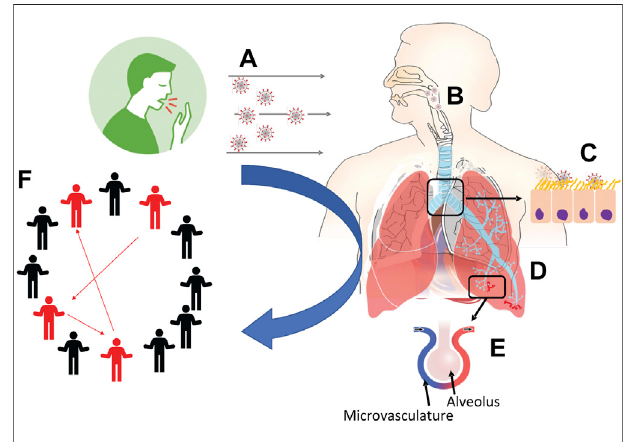
FIGURE 1 | Schematic outline of the production, transport and fate of respiratorydropletsamongindividualsasaddressedinthisarticle. (A) Exhaled breath and aerosol dynamics ( Section 2 ). (B) Fate of inhaled aerosols in the respiratory system ( Section 3 ). (C) Fate of inhaled infectious aerosols deposited at the air-airway surface liquid interface ( Section 4 ). (D) Particle distribution effect on viral binding, importance of local dose versus averages over the whole lung ( Section 5 ). (E) Endothelial dysfunction and pulmonary circulatory interactions with SARS-CoV-2 ( Section 6 ). (F) Linking personalized models to population models ( Section 7